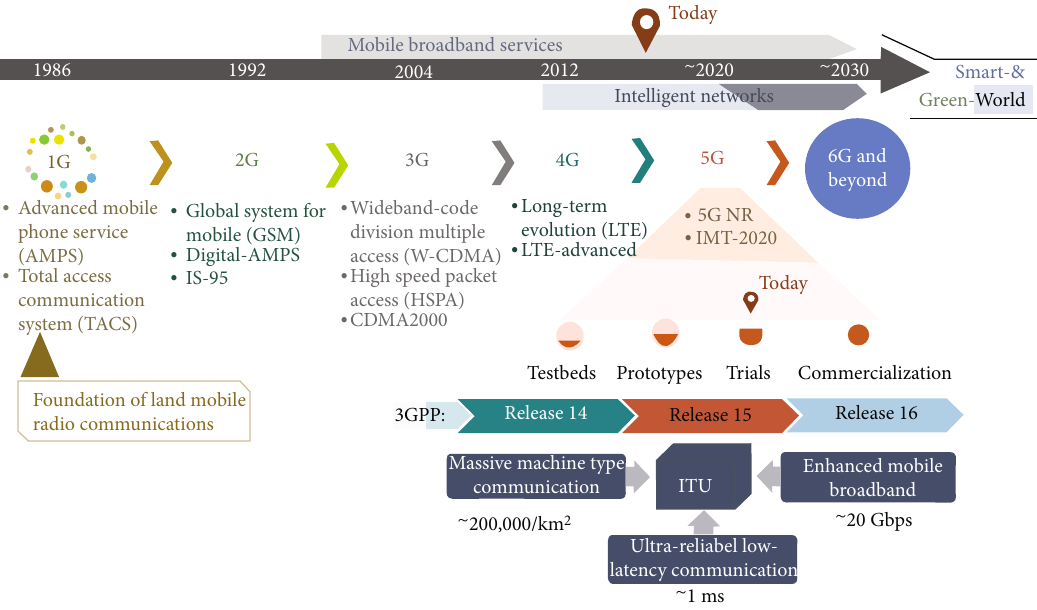
Figure 1: Trends in cellular network systems